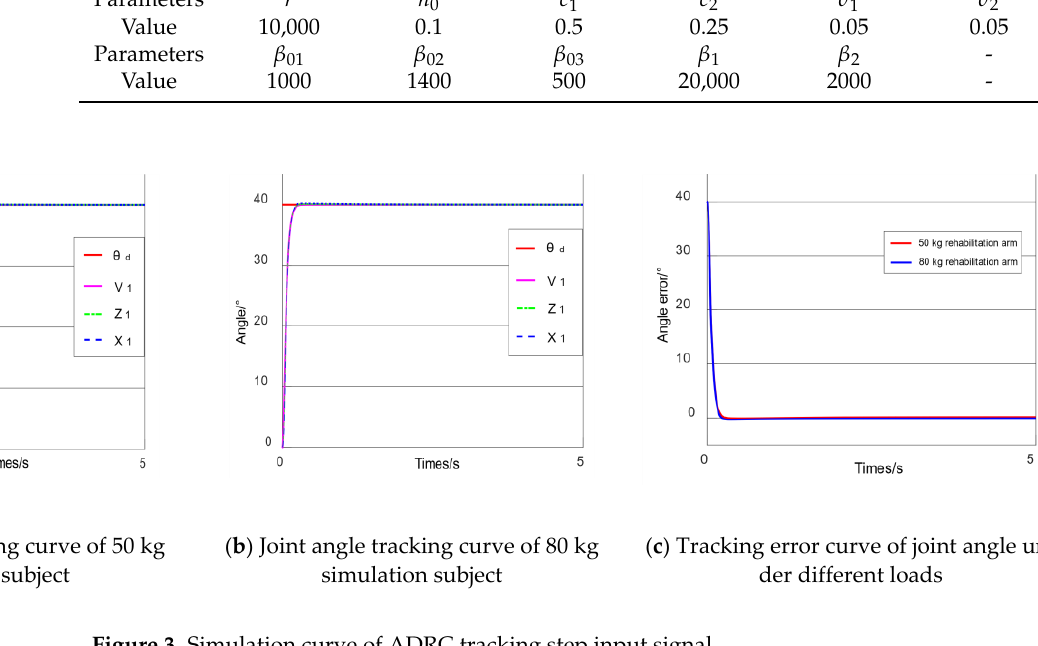
Figure 3. Simulation curve of ADRC tracking step input signal. Table 2. Parameters of PID controller simulation under step signal.